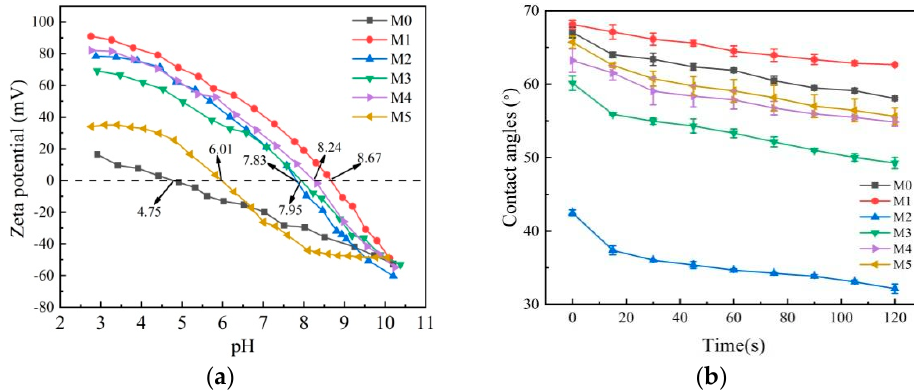
Figure 6. Zeta potentials ( a ) and contact angles ( b ) of M0, M1, M2, M3, M4, and M5 membranes.